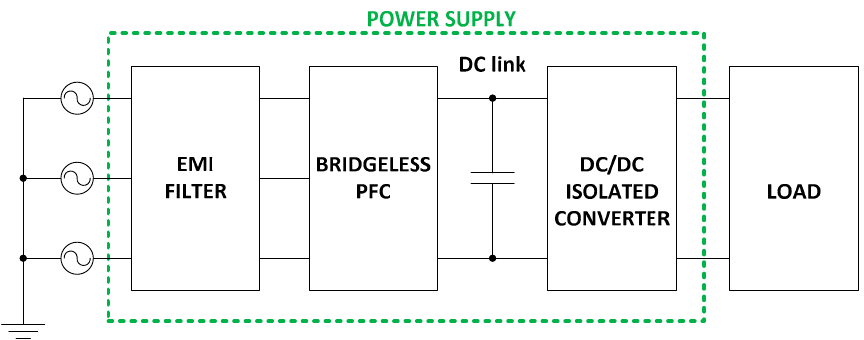
Figure 1. General block diagram of switched mode power supply.